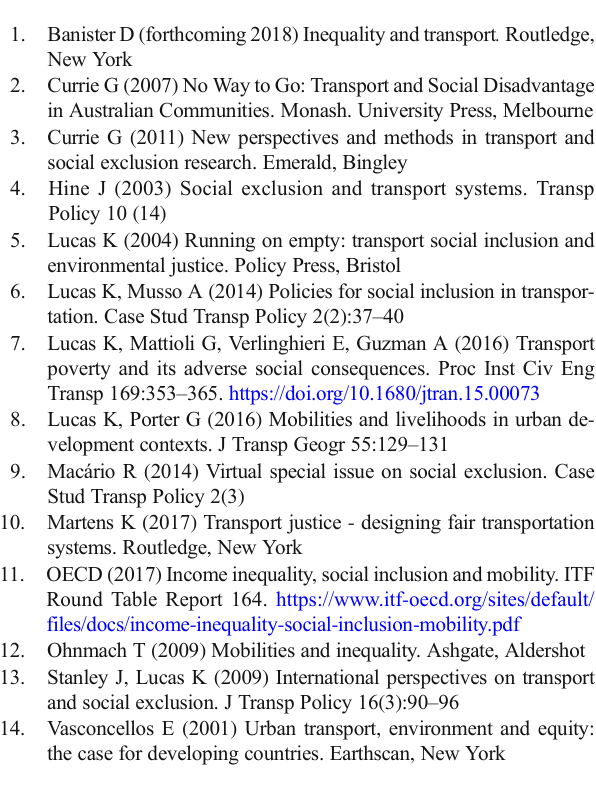
Round Table Report 164. https://www.itf-oecd.org/sites/default/